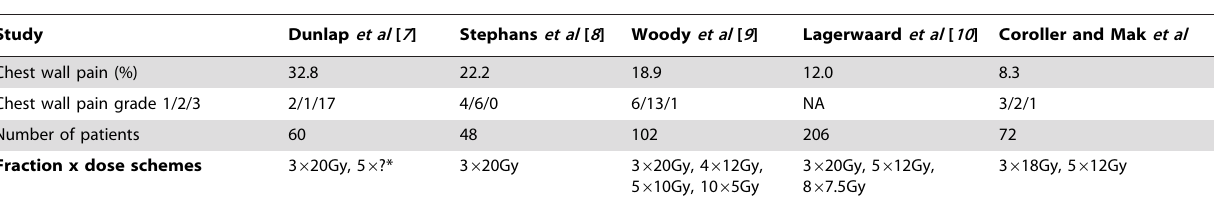
Table 5. Comparison of CW toxicity from our study versus previously reported